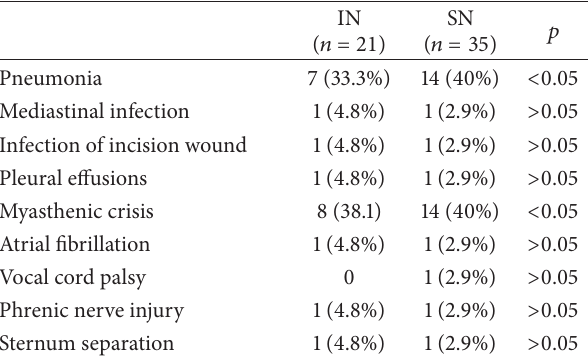
Table 3: Details of postoperative complications between two groups.